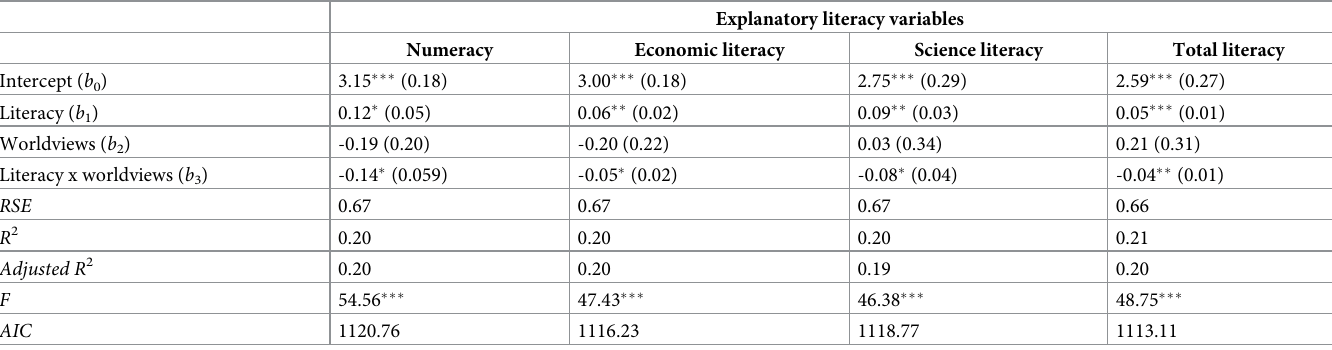
Table 1. Linear regressions